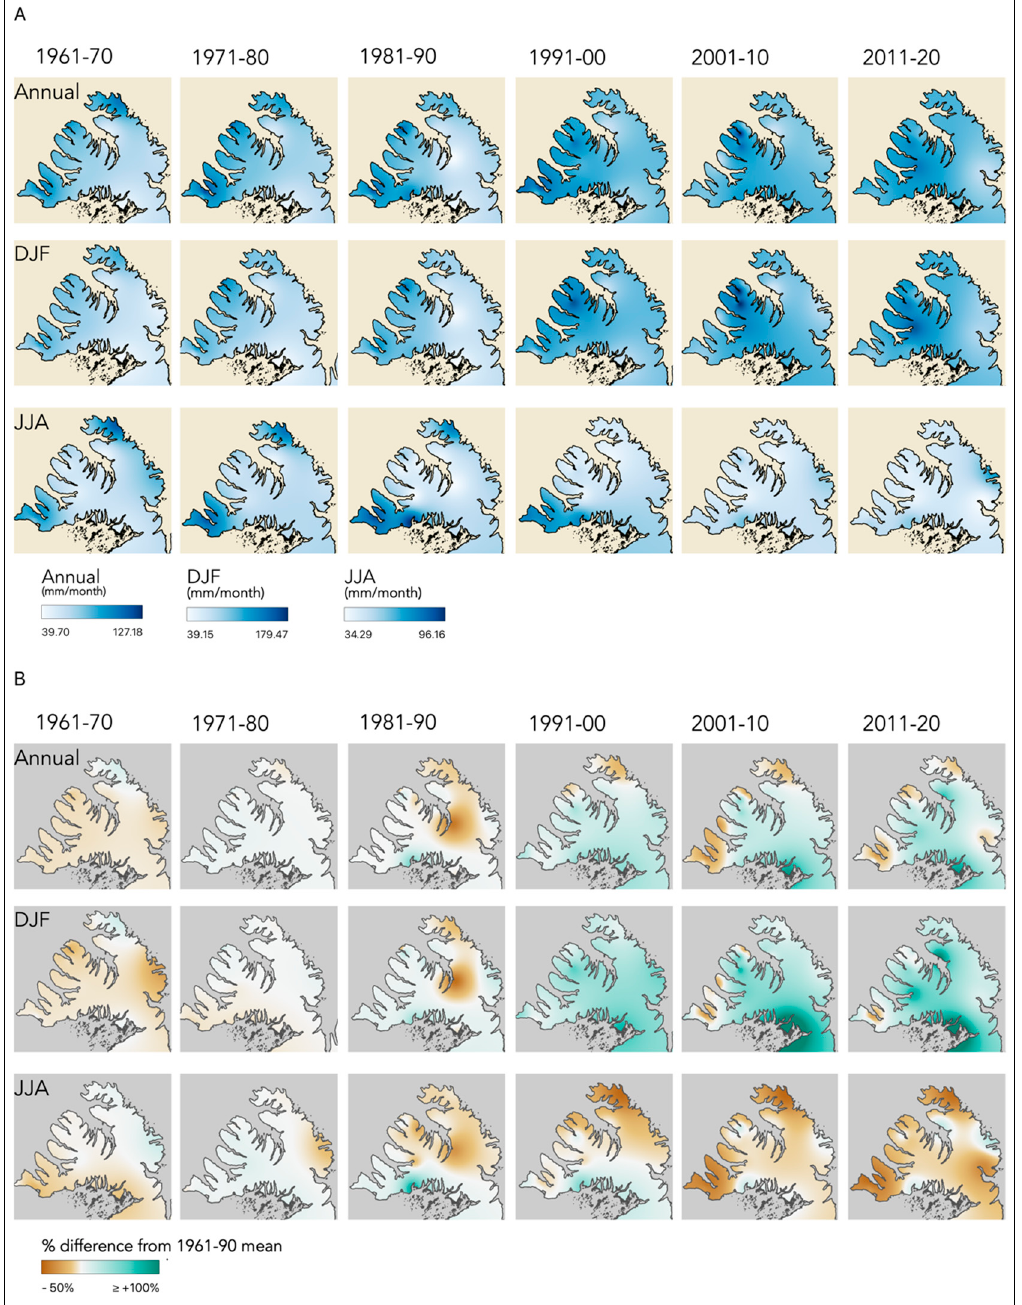
Figure 10. Spatial distribution of absolute precipitation changes ( A ) and precipitation changes relative to the 1961–1990 mean ( B ) for each decade of 1961–2020. DJF: December, January, February. JJA: June, July, August. 3.3. Local impact of climate change in the Westfjords.